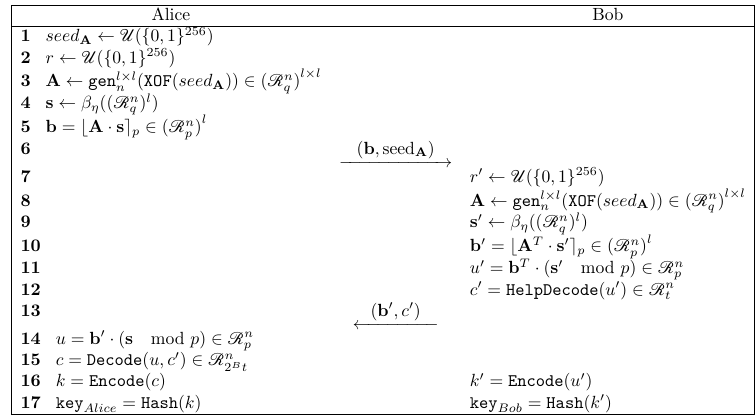
Protocol 1: A generalized key-exchange scheme based on